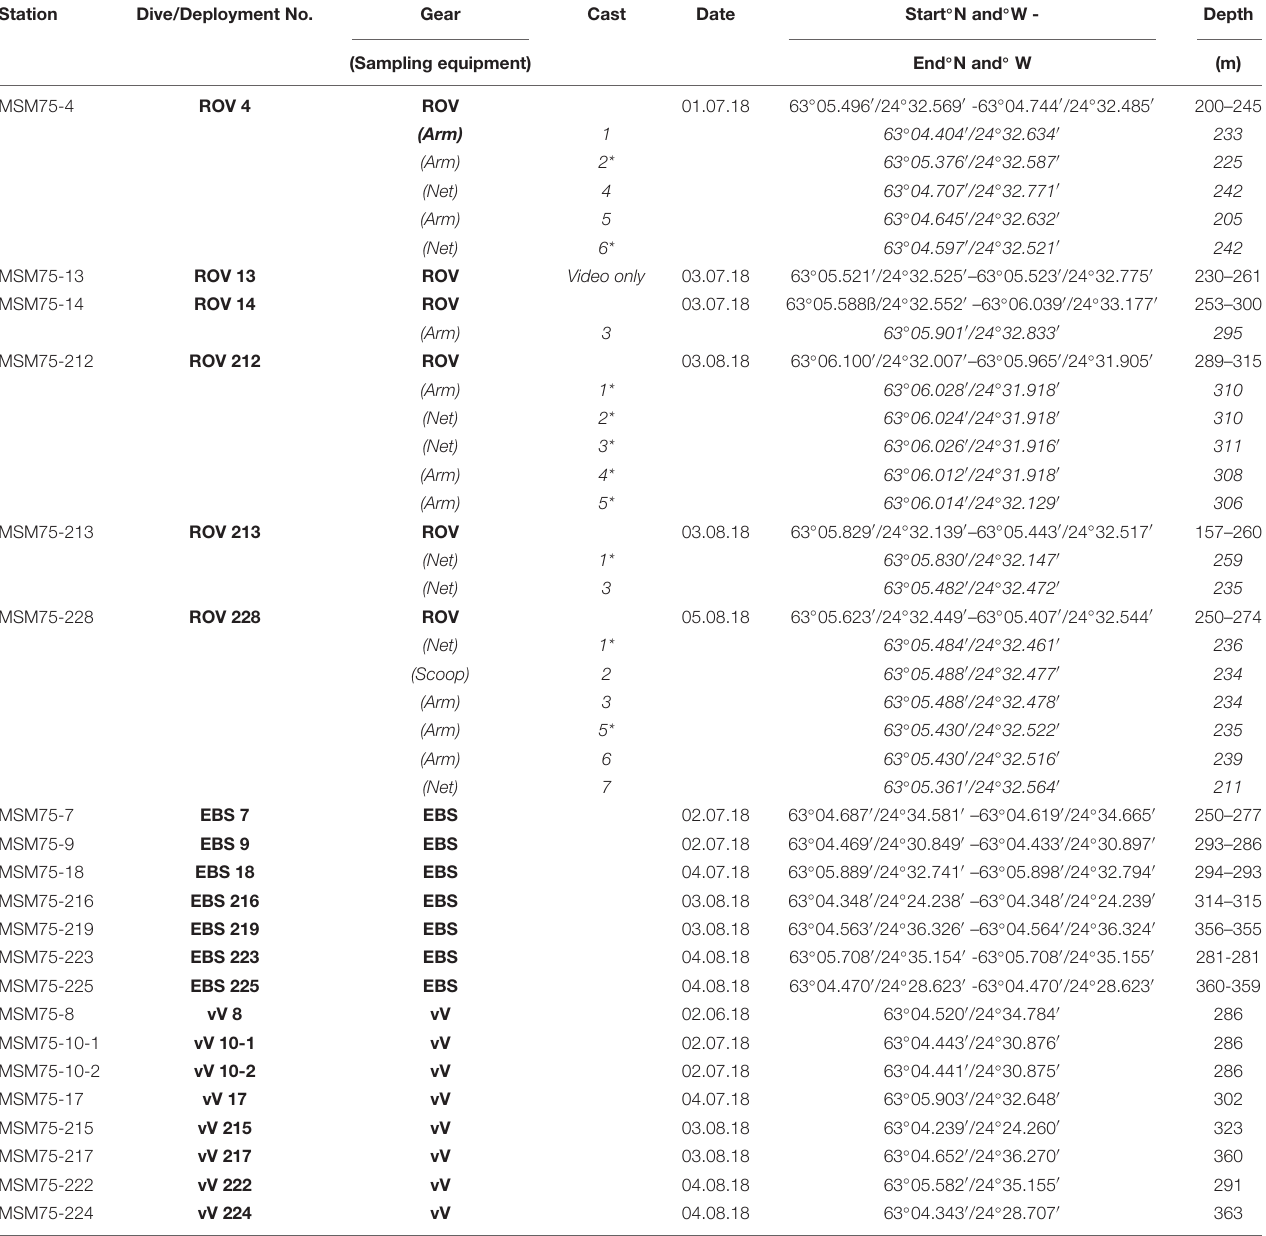
TABLE 1 | Station list of biological sampling locations; *: hydrothermally influenced sample. Station Dive/Deployment